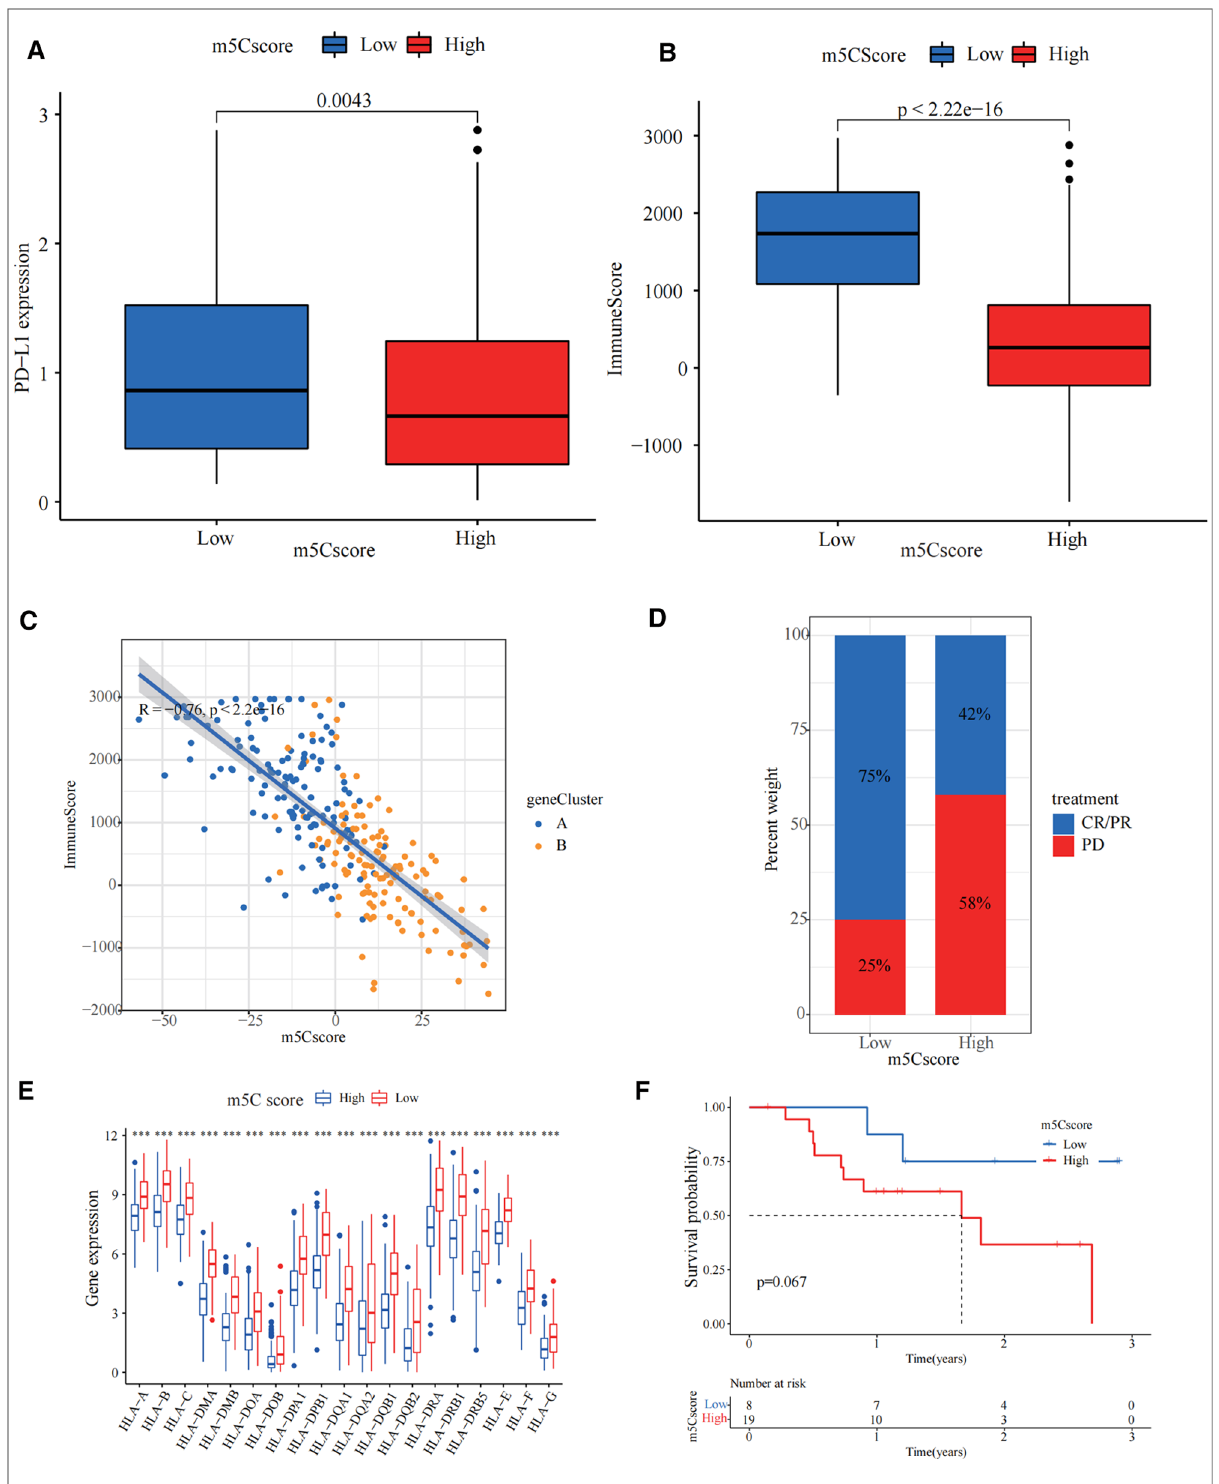
FIGURE 5 Guidance of 5-methylcytosine (m5C) score for immunotherapy. ( A ) PD-L1 expression was signi fi cantly higher in the low m5C score group than in the high m5C score group ( p =0.0043). ( B ) The immune score in low m5C score group is higher than high m5C score group ( p <2.22×10 − 16 ). ( C ) Immune scoring also showed a signi fi cant negative correlation with m5C score. ( D ) The bar chart demonstrates the different immunotherapy effects in high and low m5C score groups. ( E ) HLA family expression was signi fi cantly higher in the low m5C score group than in the high m5C score group (*** p <0.001). ( F ) Kaplan-Meier curves for high and low m5C score patient groups in the GSE78220 cohort (Log-rank test p